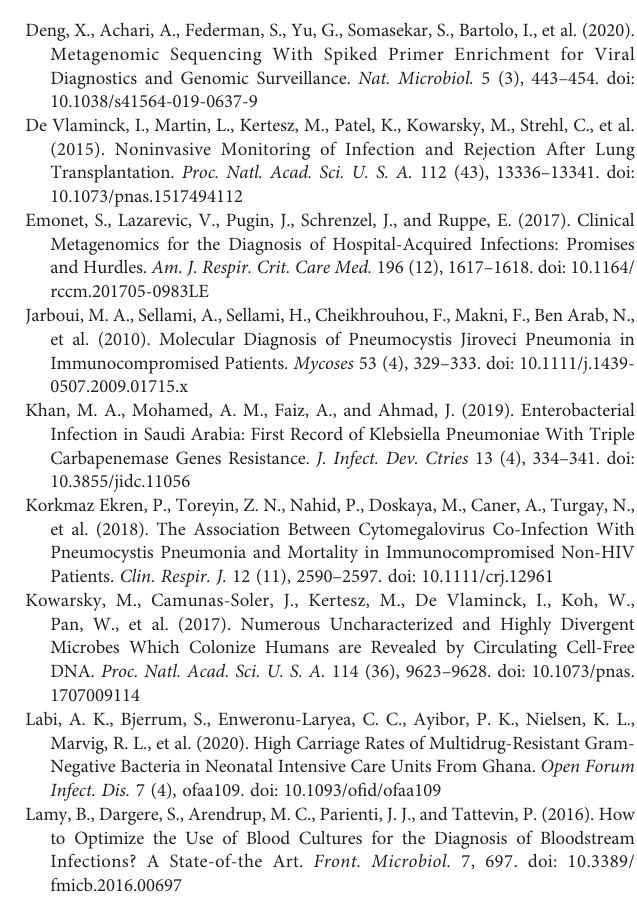
Supplementary Figure 3 | Protozoan nucleic acid sequences in the bloodstream of children in PICU. (A) the nucleic acid sequence of potential protozoa in the bloodstream of children in PICU. (B) heat map of potential protozoa in the bloodstream of children in PICU. (C) the richness (Chao 1) of bloodstream protozoa in children with immunode fi ciency was signi fi cantly higher than in children without immunode fi ciency, P < 0.05, Wilcoxon rank-sum